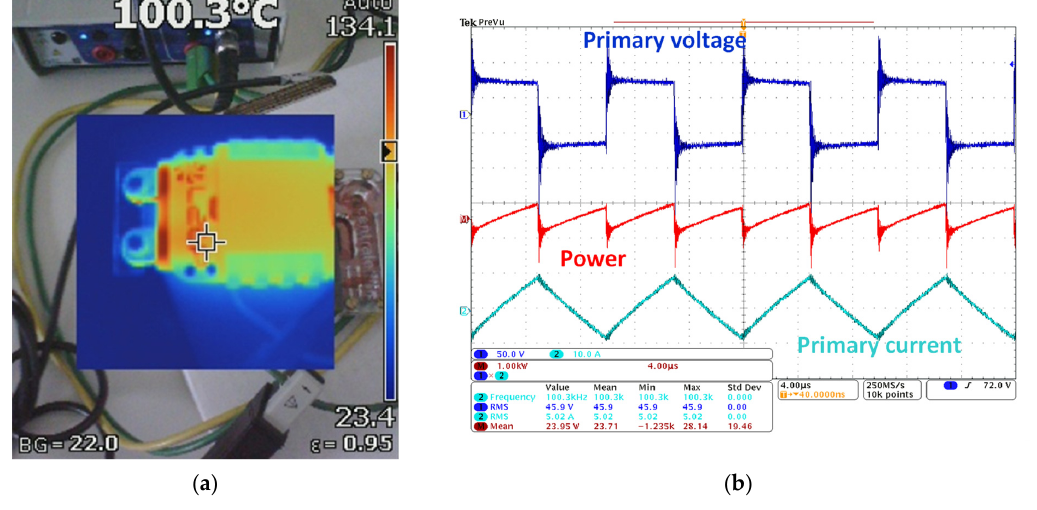
Figure 12. Thermal characterization—short-circuit test: ( a ) temperature distribution; ( b ) voltage, current and power wave- forms.